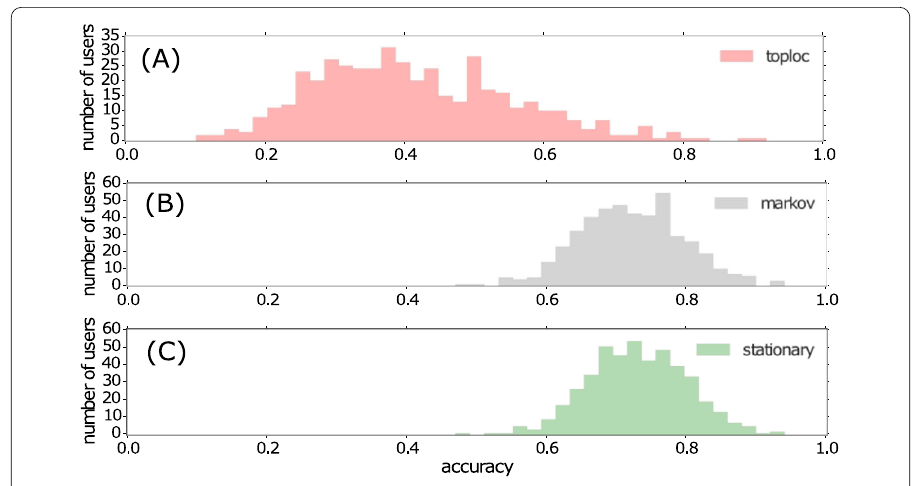
Figure 2 Accuracy of the prediction in the next-cell formulation. (A) The results of the toploc strategy, that predicts the most common location at each step. (B) The accuracy for the Markov chain model. (C) The accuracy for the stationary strategy, that predicts remaining stationary in the previous cell.